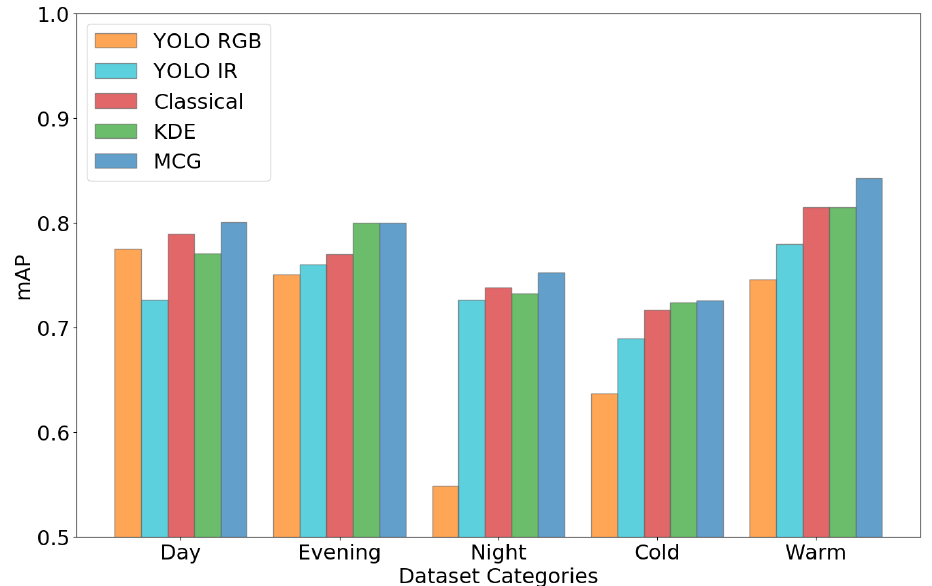
Figure 7. Comparison of different implementations for the proposed fusion and YOLO detections.